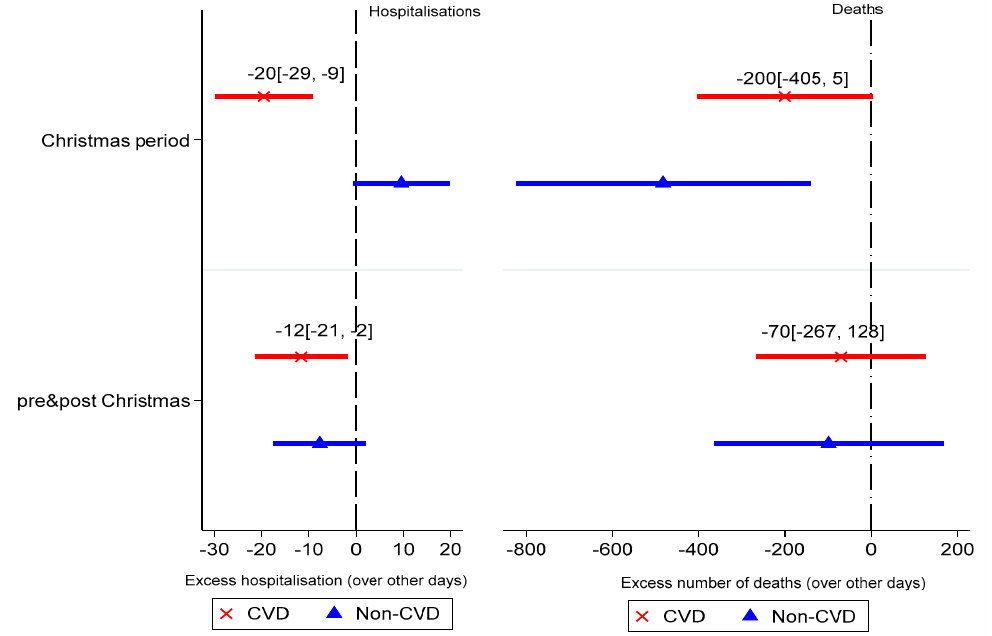
Figure 3. CVD- and non-CVD-related events during December holidays.